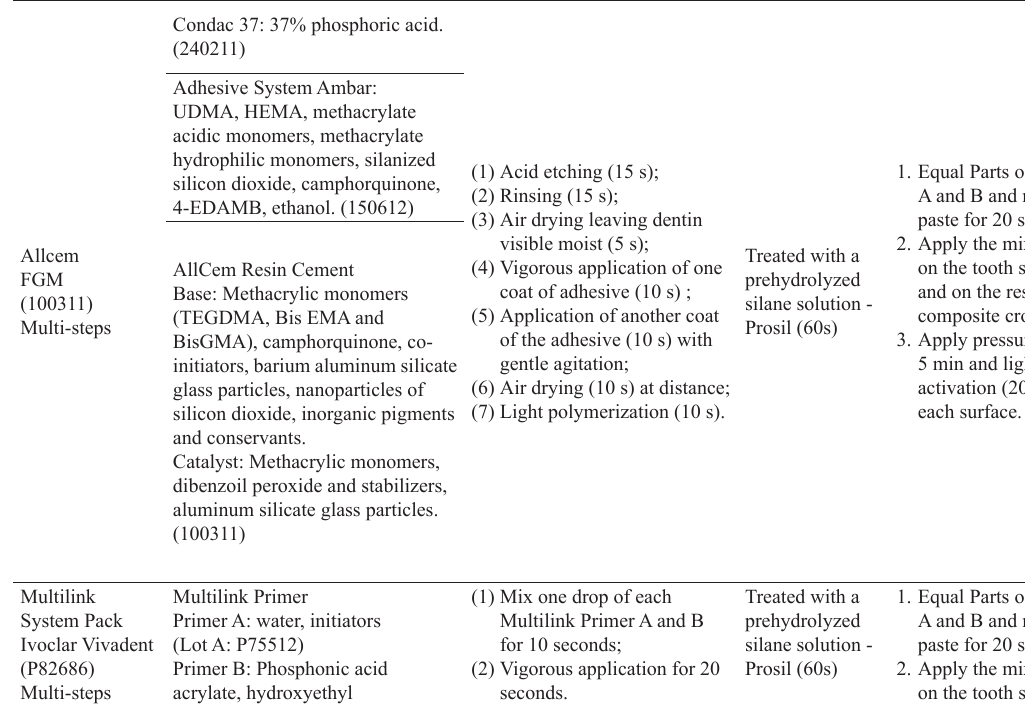
Table 1 – Cements, batch number, manufacturers, composition, and application technique. Cements Composition (Manufacturers) (batch